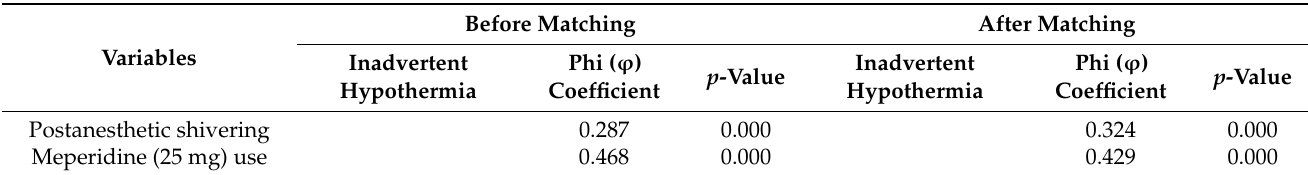
Table 4. Association of inadvertent intraoperative hypothermia with postanesthetic shivering and meperidine use.